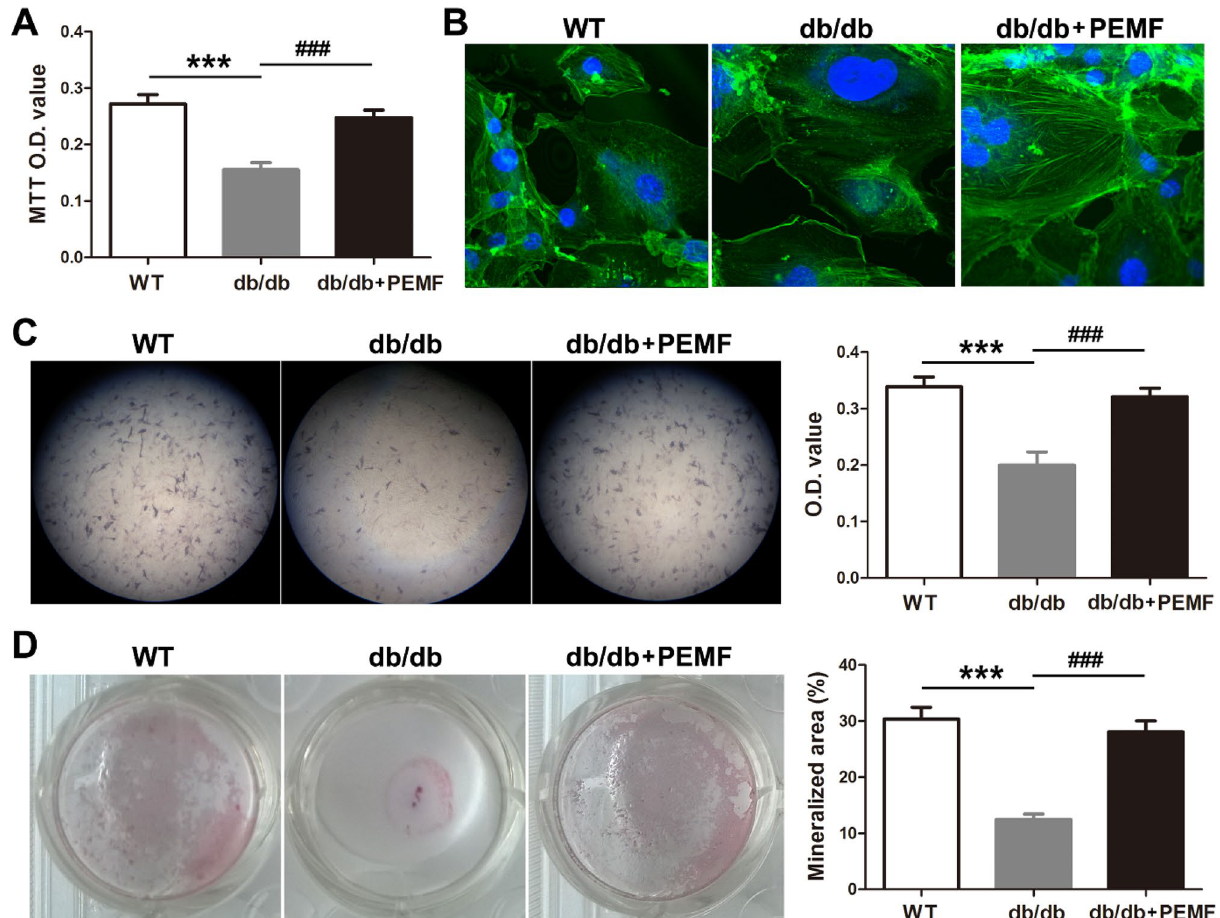
Figure 3. Pulsed electromagnetic fields (PEMF) exposure improves in vitro osteoblast viability and accelerates osteoblast differentiation in primary osteoblasts isolated from mandibular bone of type 2 diabetic db/db mice. ( A ) MTT assays for in vitro primary osteoblast proliferation. ( B ) F-actin cytoskeleton imaging of in vitro primary osteoblasts based on FITC-labeled phalloidin staining. ( C ) In vitro osteoblast differentiation assays based on alkaline phosphatase staining. ( D ) In vitro osteoblast mineralization assays based on Alizarin red staining of the mineralized nodule. Data are represented as mean ± SEM ( n = 7–10/group). *** P < 0.001 vs. the WT group; ### P < 0.001 vs. the db/db group by one way analysis of variance (ANOVA) followed by Bonferroni’s multiple